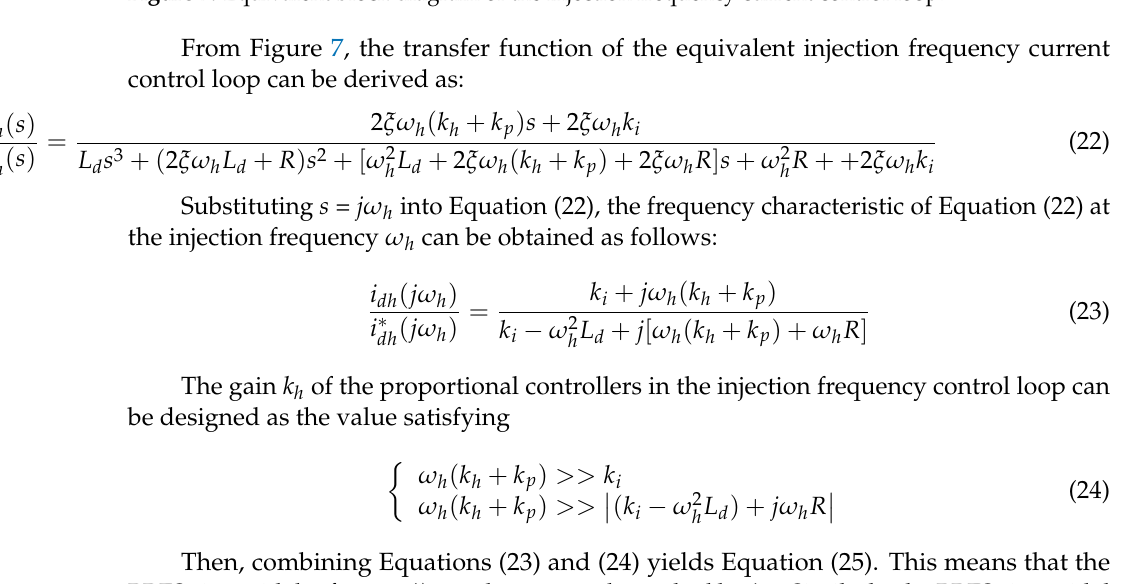
Figure 7. Equivalent block diagram of the injection frequency current control